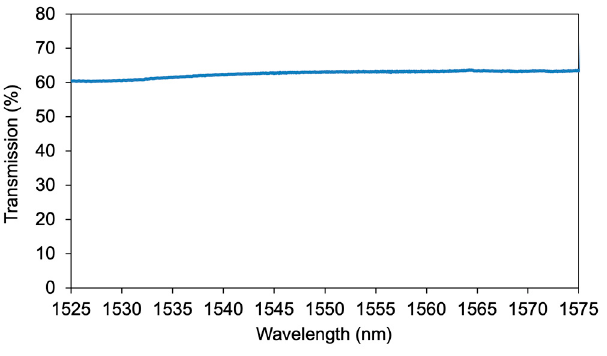
Figure 3. Transmission loss of GNP-SAs across conventional band (C-band) wavelength region.